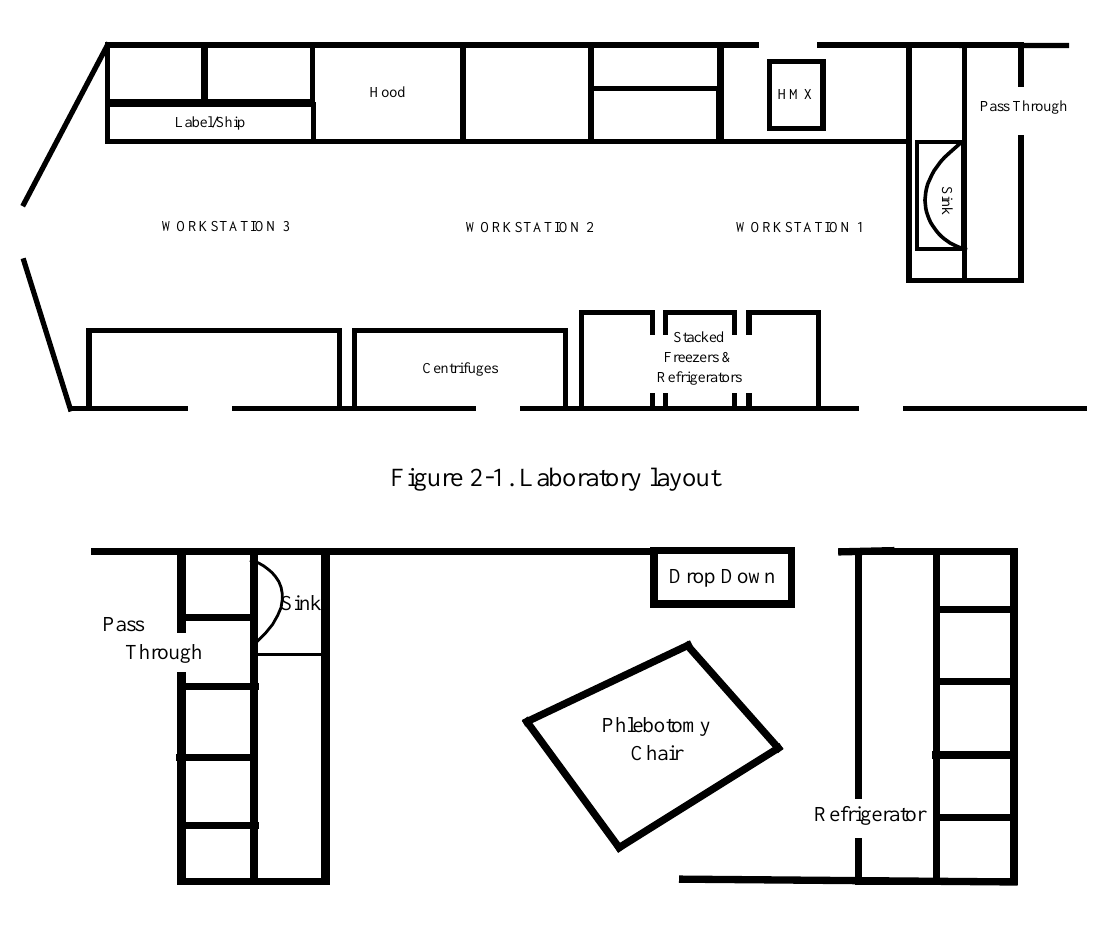
Figure 2-2. Phlebotomy room